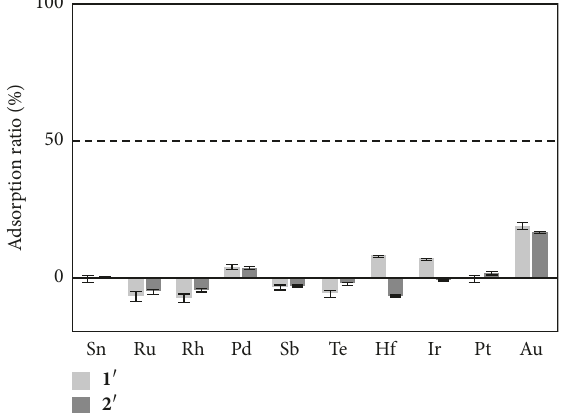
Figure 5: Metal adsorption from multielement solution A with hydrophilic gels 1 and 2 ′ ′